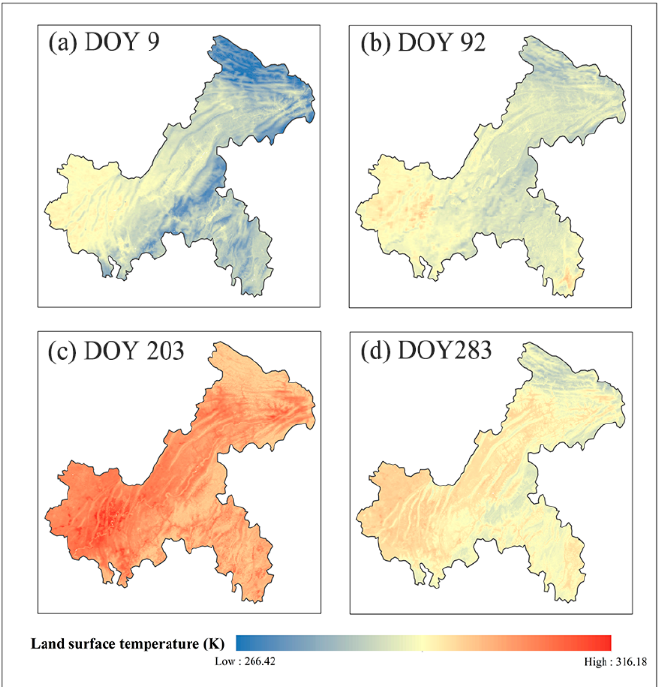
Figure 8. Reconstructed LST images on four days in 2018 (DOY 9, DOY 92, DOY 203 and DOY 283).